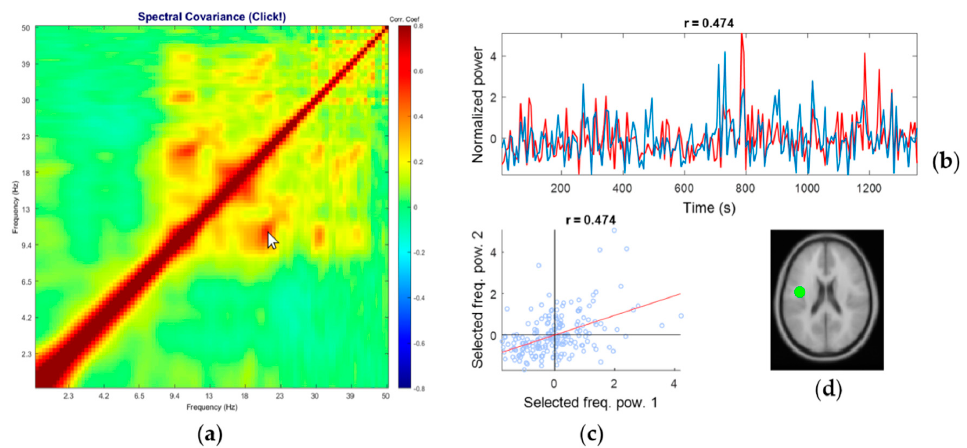
Figure 3. A representative comodulogram of Brain-Class (Subject 20, IC No. 26): ( a ) the comodulogram; ( b ) time series of the cross-frequency PPC of the combinations of the selected frequency bins specified by the cursor position on the comodulogram; the currently selected pair is 10.7 Hz and 21.3 Hz, and their correlation coefficient is 0.474; ( c ) the scatter plot of PSD from individual windows of the selected pair; ( d ) the corresponding equivalent current dipole model localized at ( − 43, − 4, 27) in Talairach coordinates, which corresponds to Brodmann Area 6. Note the isolated islands of the red blobs with the regular intervals on the log scale, which indicates harmonics that are integer multiples of the fundamental frequency (i.e., alpha band).